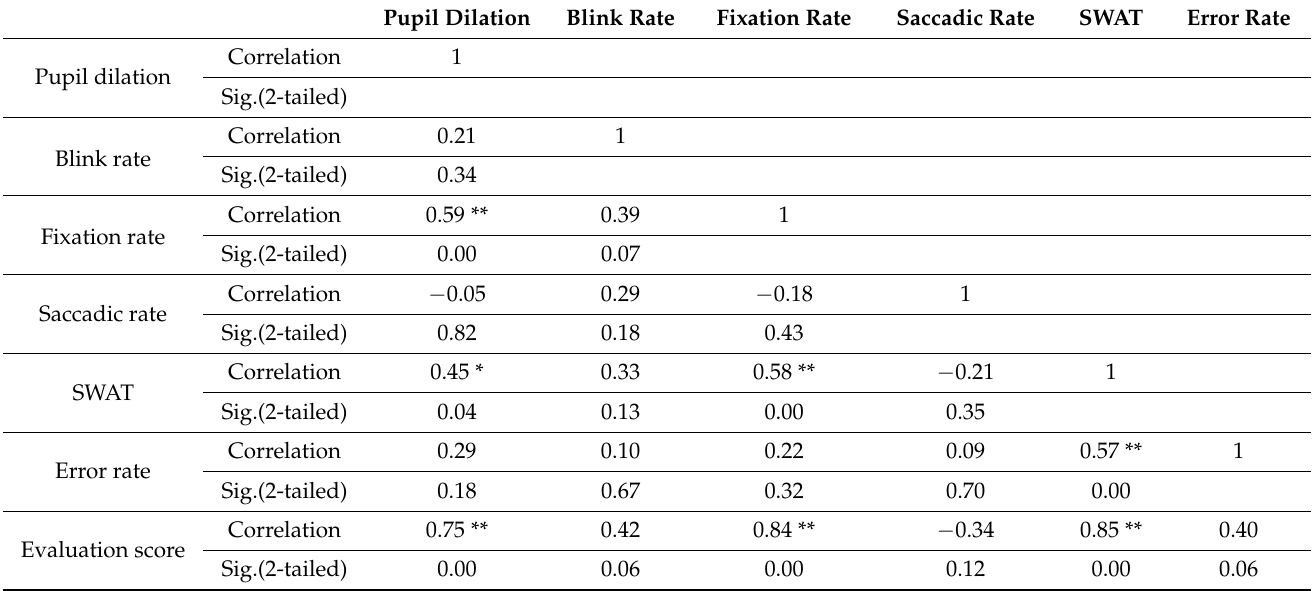
Table 6. Correlation between the evaluation score and other indices